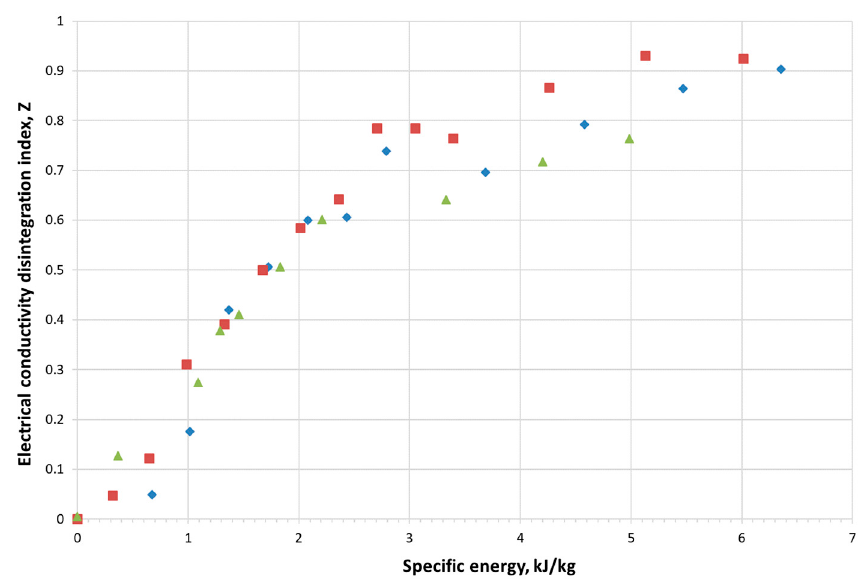
Figure 1. Relation between energy supplied during PEF treatment and the electrical conductivity disintegration index (various symbols and colours represent 3 different repetitions of the measure- ments).